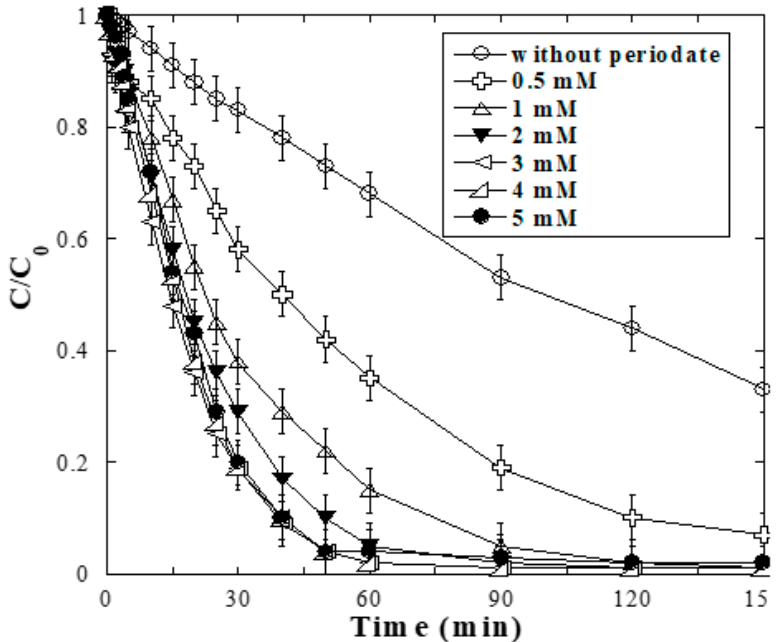
Figure 5. AO10 degradation kinetics versus [IO 4- ] 0 ([AO10] 0 = 50 mg/L, Temp. 20 ± 1 °C, initial pH 5.4, irradiation intensity: 15 mW/cm²).